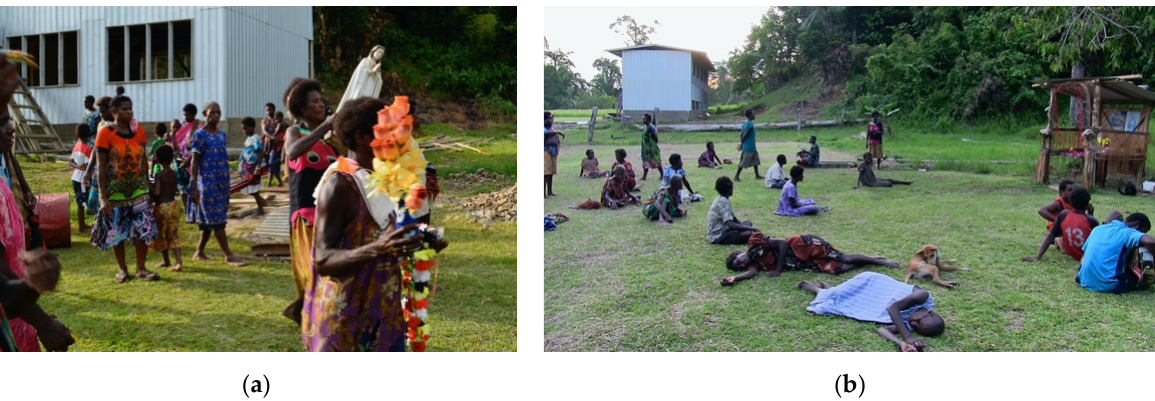
Figure 3. ( a ) The statue of Mother Mary dancing in the arms of a woman during a Marian procession in October 2013 (photo: Falck 2013); ( b ) two women recuperating from spirit possessions towards the end of a charismatic prayer meeting during October 2013 (photo: Falck 2013).